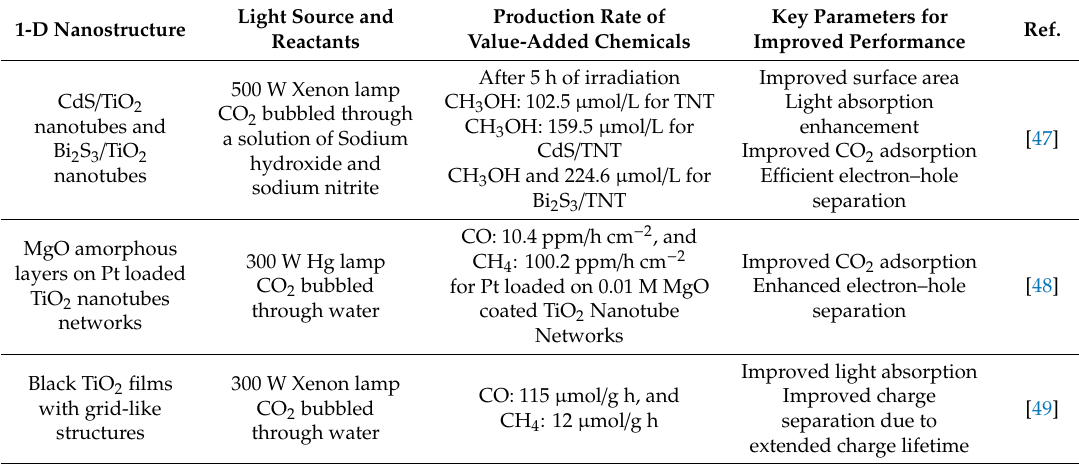
Figure 6. ( a ) Schematic overview of the synthesis procedure for FANT, and ( b ) the proposed mechanism for photocatalytic conversion of CO 2 into CH 4 employing the FANT photocatalyst (taken with permission from [61]). Table 2. Summary of various 1-D nanostructured photocatalysts, including reaction conditions, production of value-added chemicals by photocatalytic CO 2 conversion, and key parameters for performance improvement.